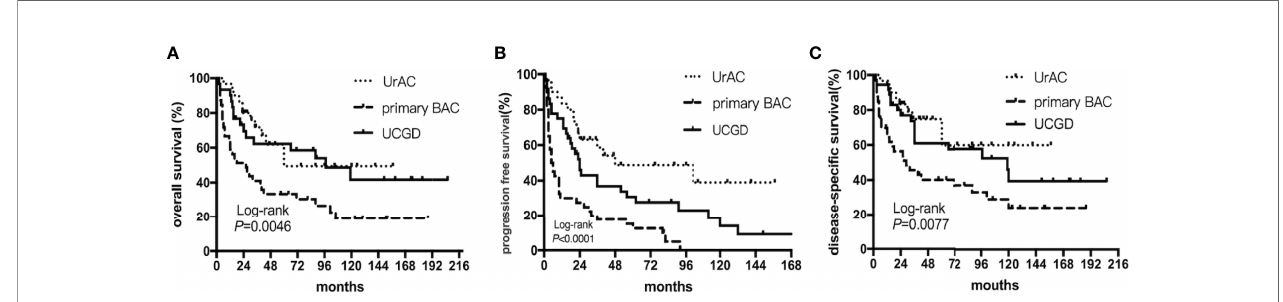
FIGURE 1 | Kaplan – Meier curves of patients strati fi ed according to tumor type: UrAC vs . primary BAC vs . UCGD. (A) overall survival ( P =0.0046, log-rank test). (B) progression free survival ( P <0.0001, log-rank test). (C) disease-speci fi c survival ( P =0.0077, log-rank